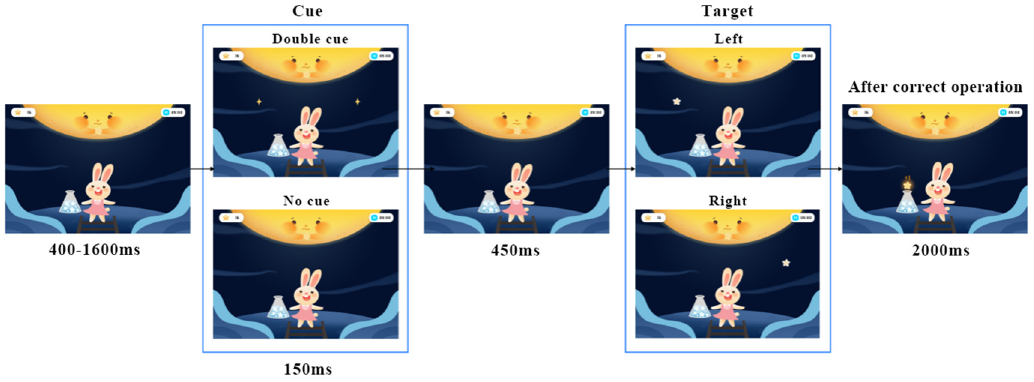
Figure 6. The sequence of events of the alerting game (authors’ proposal).